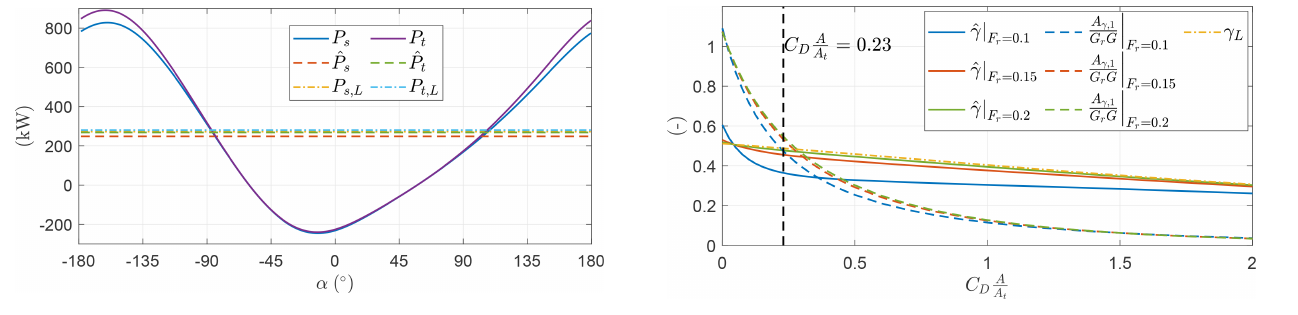
Figure 22. Optimal values of ˆ γ and A γ, 1 , normalized with G r G as a function of C D A for different Froude numbers. A t